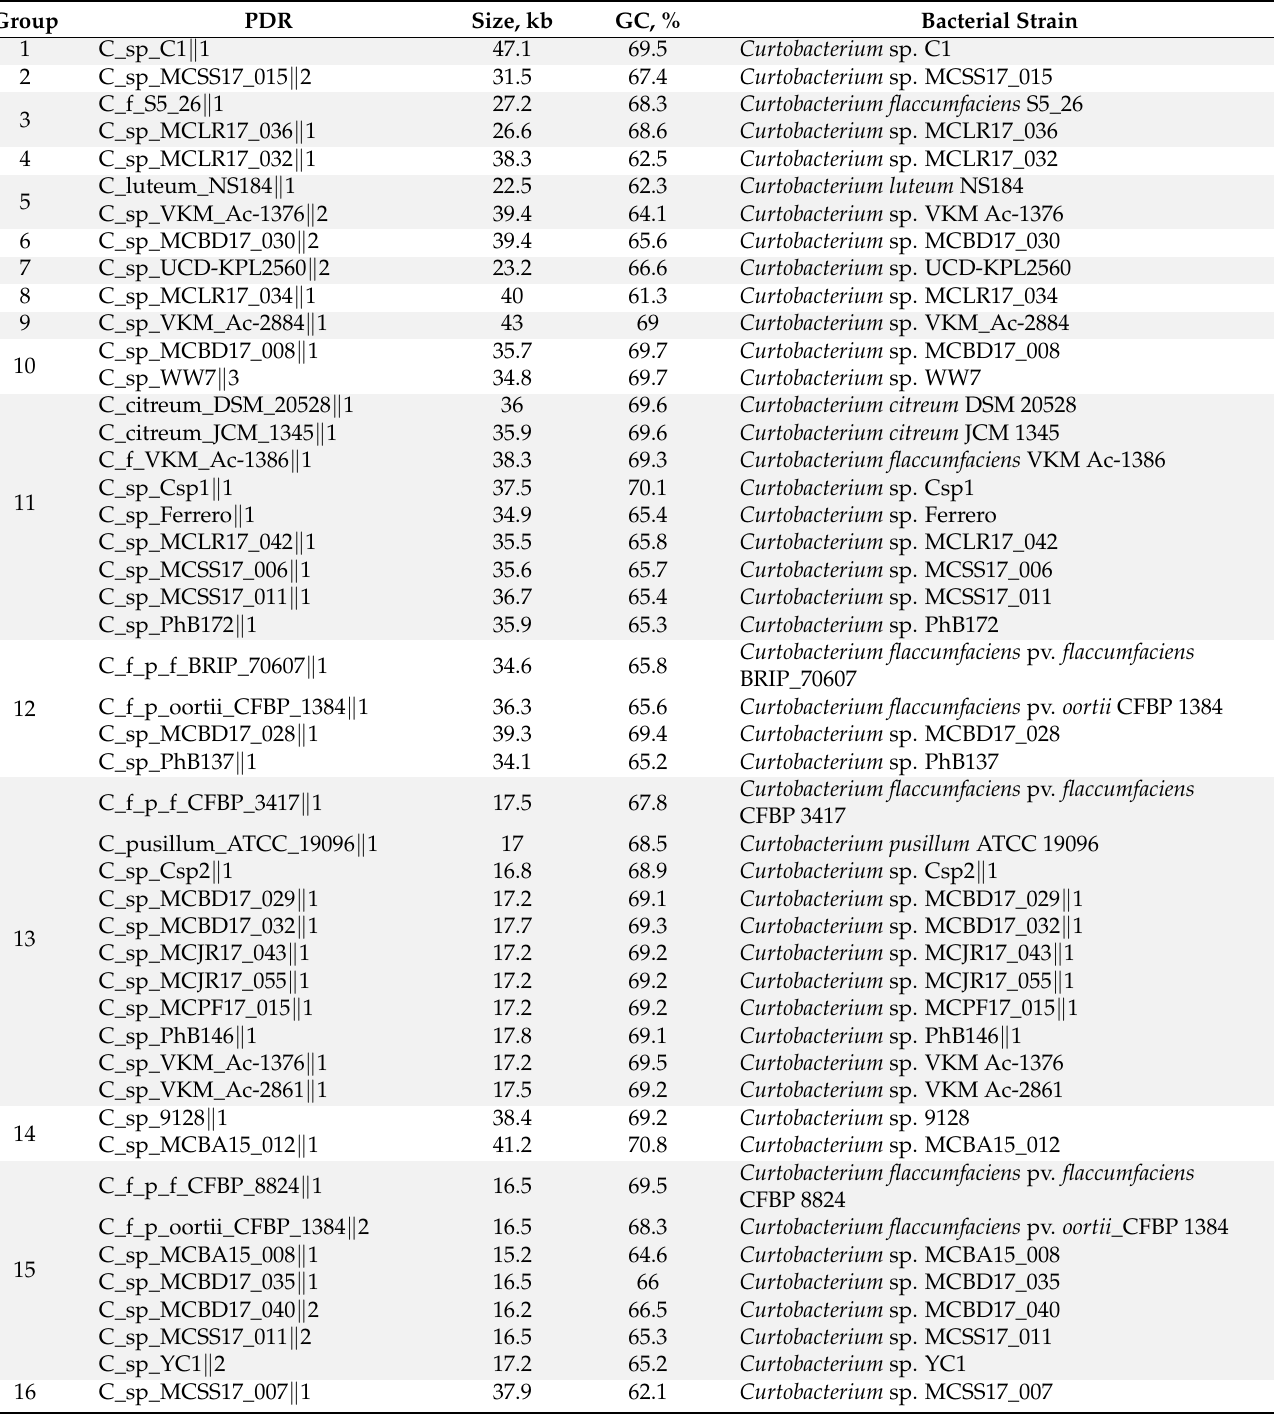
Table 1. General features of genomes of curated, predicted, prophage-derived regions